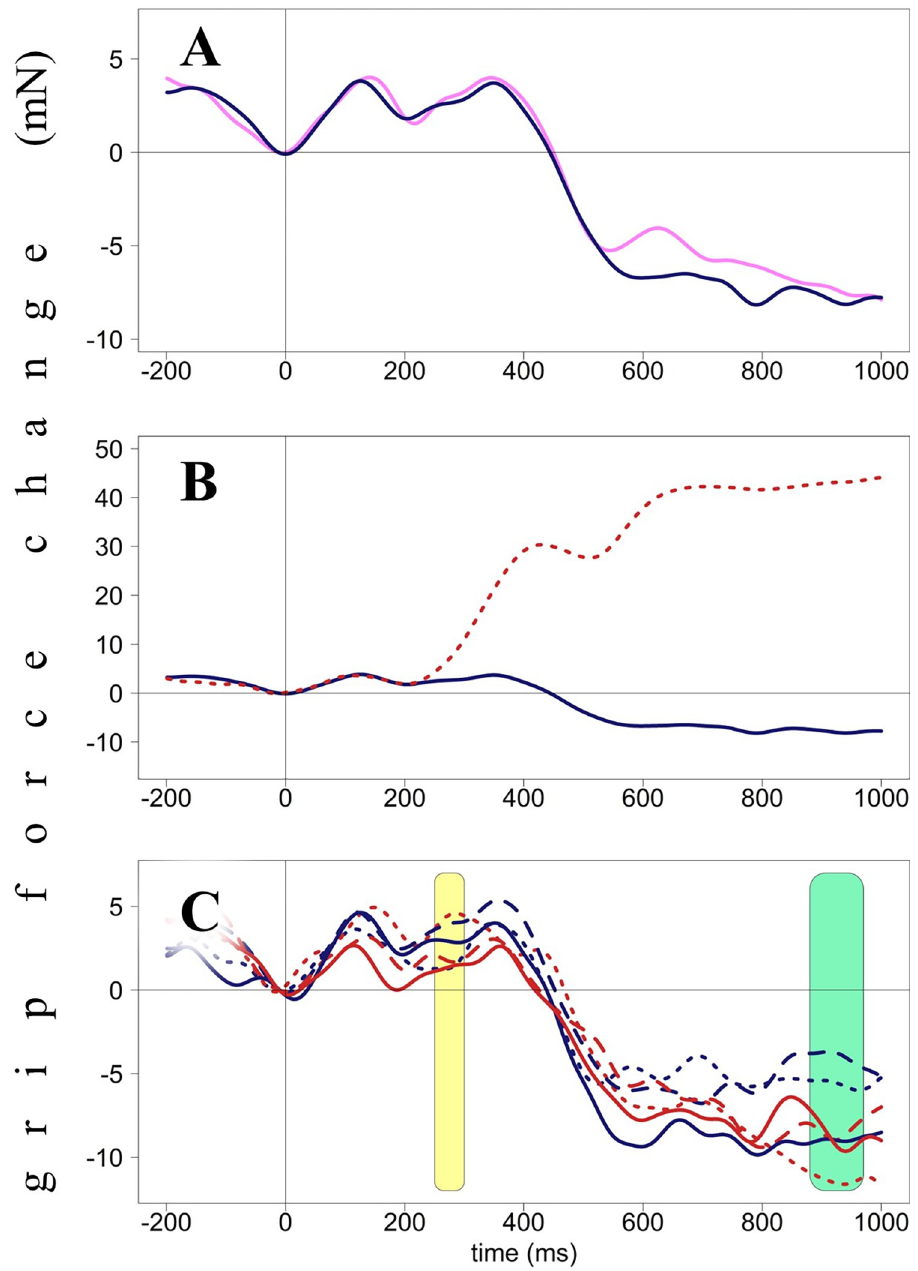
Fig 9. Grip force changes (in milli-Newton) plotted against time from stimulus onset (in milliseconds), Experiment 3. Panel A. Averaged force profiles across all accepted no-go trials of all participants plotted for words (blue line) vs. symbol arrays (pink line). Panel B. Force profiles in go (dotted red line) and no-go (solid blue line) trials. These forces diverge around 230 ms after stimulus presentation. Panel C. Force profiles averaged by condition (Hand X Word). Yellow area (250–300 ms) indicates interaction between Hand and Word. Green area (880–970 ms) indicates the main effect of Hand (not significant). Red lines represent right-hand forces, blue lines–left-hand forces. Dotted lines represent the word-left condition, solid lines–word-center, dashed lines–word-right.